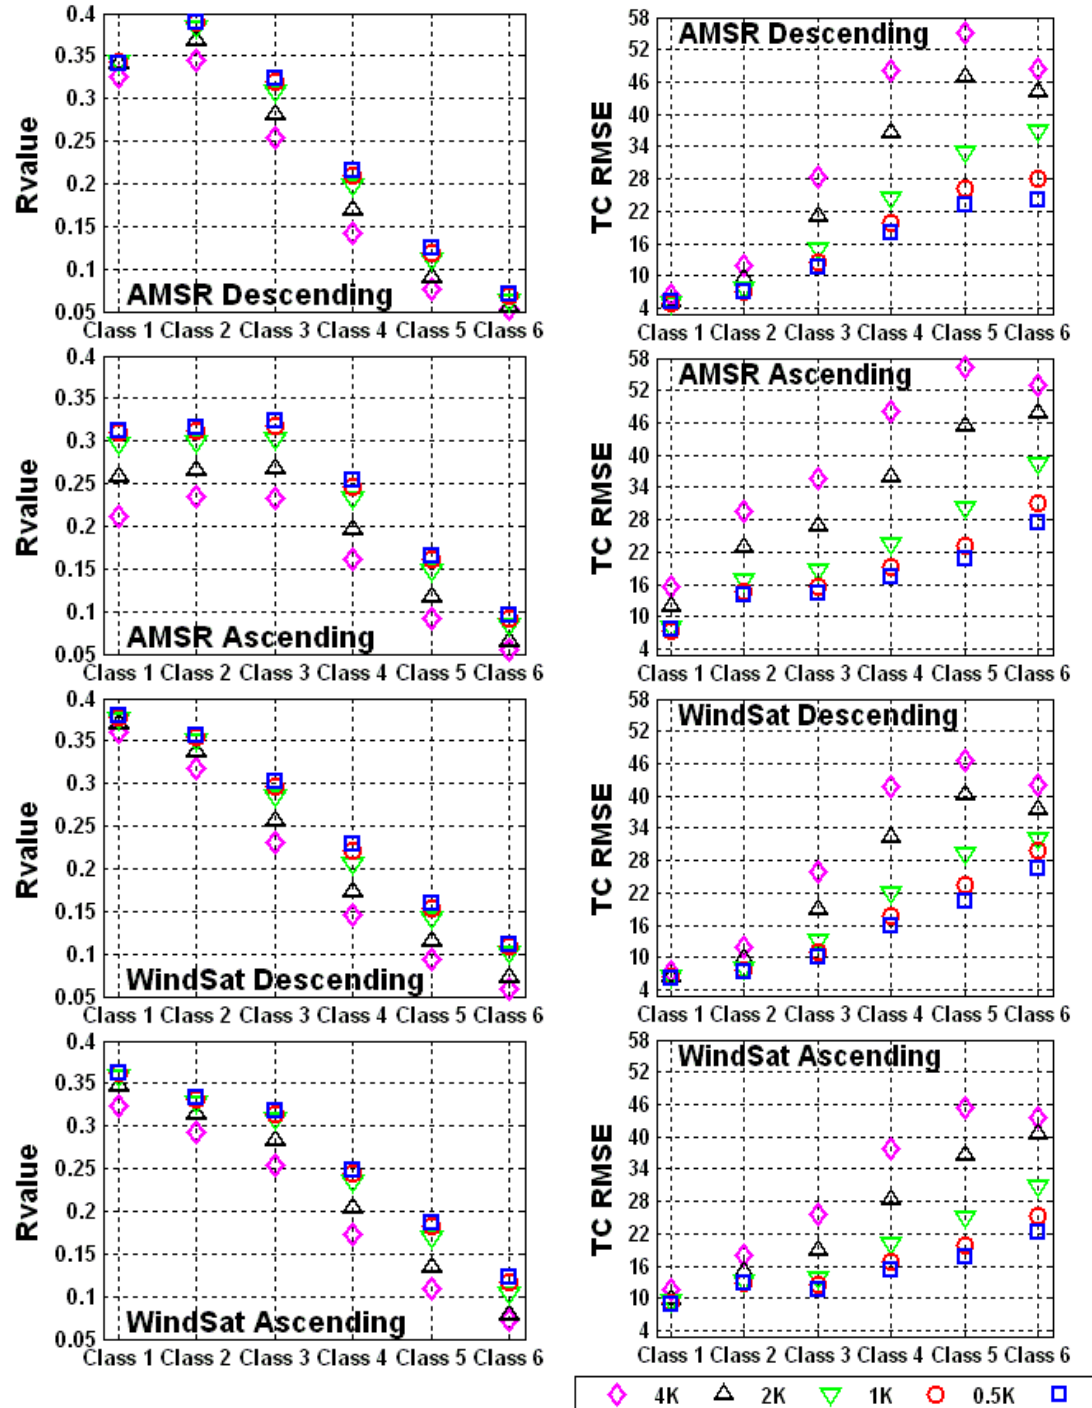
Fig. 8. Effect of degrading the T Ka on the soil moisture anomaly detection skill according to the R value (left) and the TC method (right) for the different overpass times of AMSR-E and WindSat. Each graph shows the average of the global results for six different vegetation classes (Table 1), and the different symbols indicate the level of artificial Gaussian noise applied to the T Ka before inputting to the retrieval algorithm.